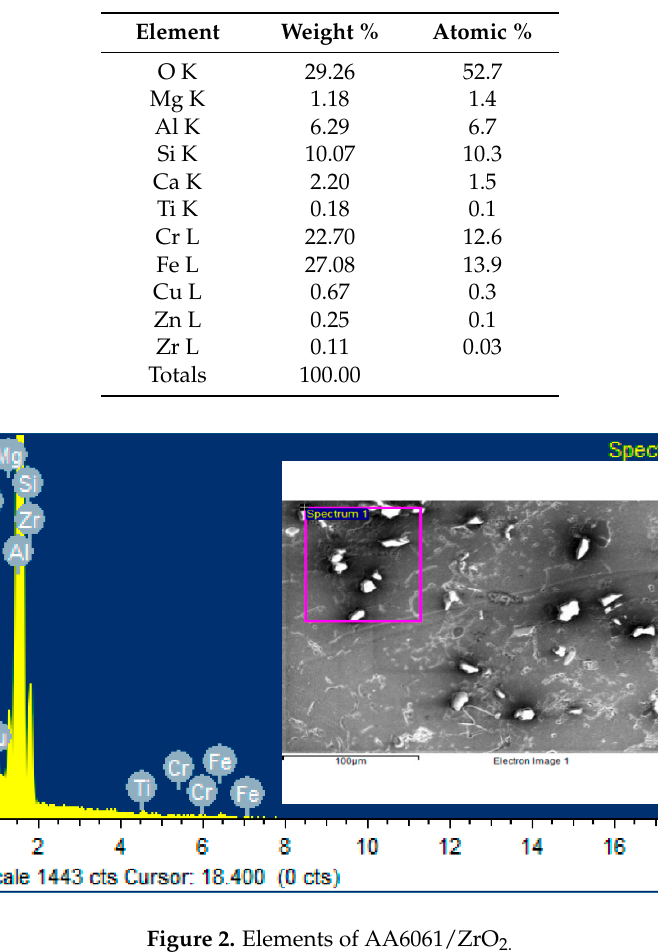
Figure 2. Elements of AA6061/ZrO 2.